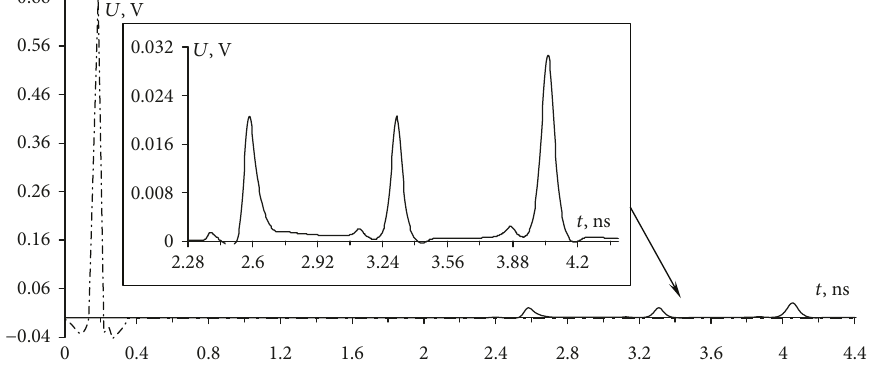
Figure 10: Voltage waveforms at the input ( – · – ) and output ( — ) (with enlarged fragment of the signal at the output) of a three-conductor microstrip line MF after four-criterion GA optimization.